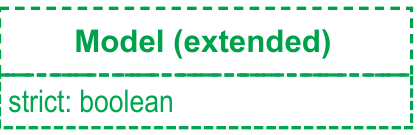
Figure 2: A UML representation of the extended SBML Model class used in the Flux Balance Constraints package. See Section 1.4 for conventions related to this figure.